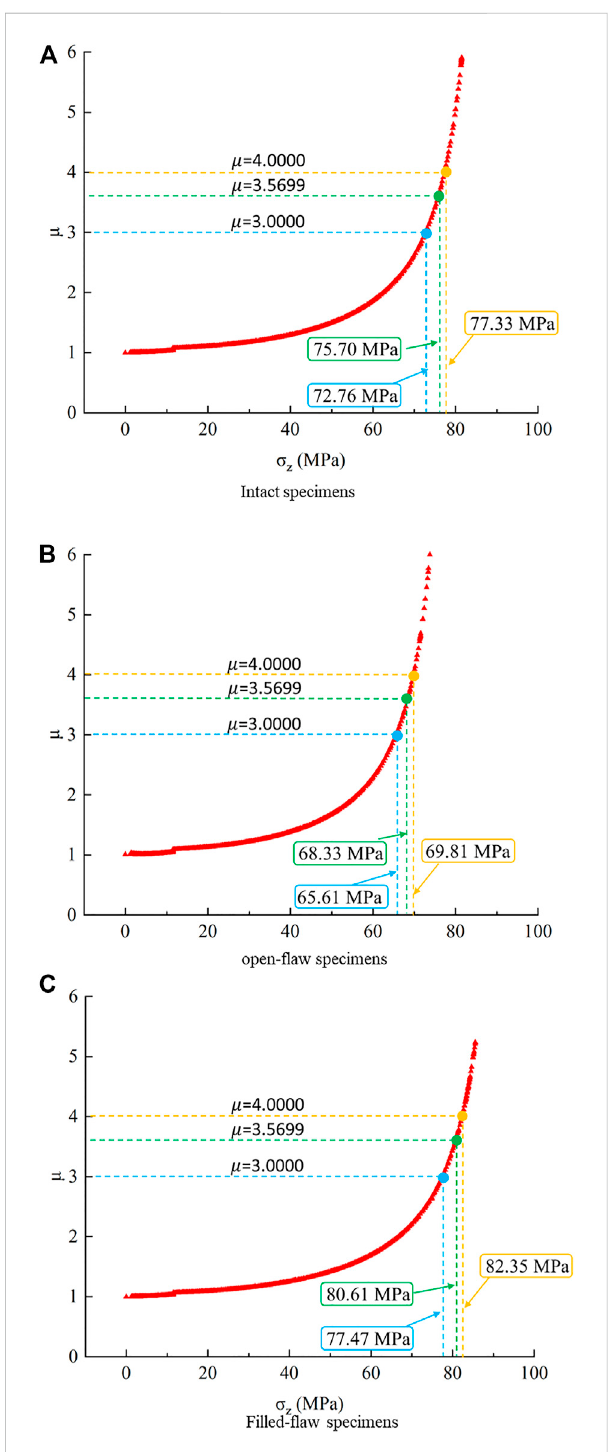
FIGURE 6 Variation of μ with maximum principal stress under the three surrounding rock conditions: (A) intact specimens; (B) open- fl aw specimens; (C) fi lled- fl aw